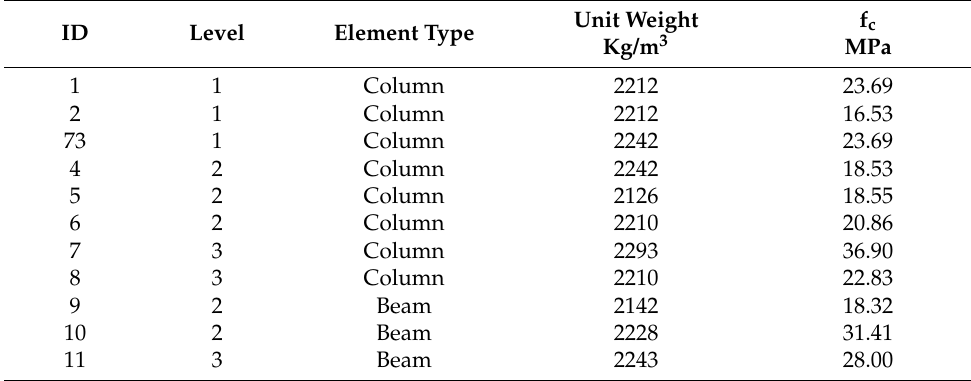
Table 1. Concrete compressive strength: columns and